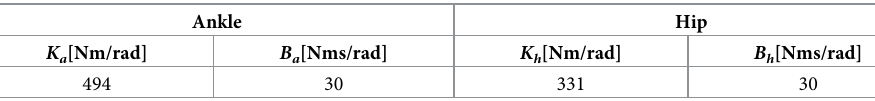
Table 2. Visco-elastic parameters of the DIP